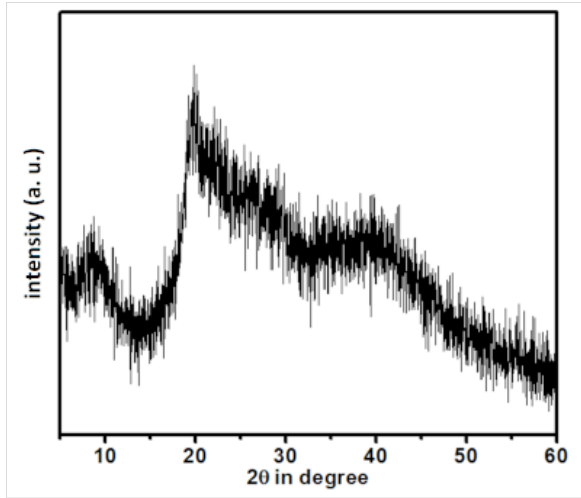
Figure 2: PXRD data for the Ni–chitosan NPs.